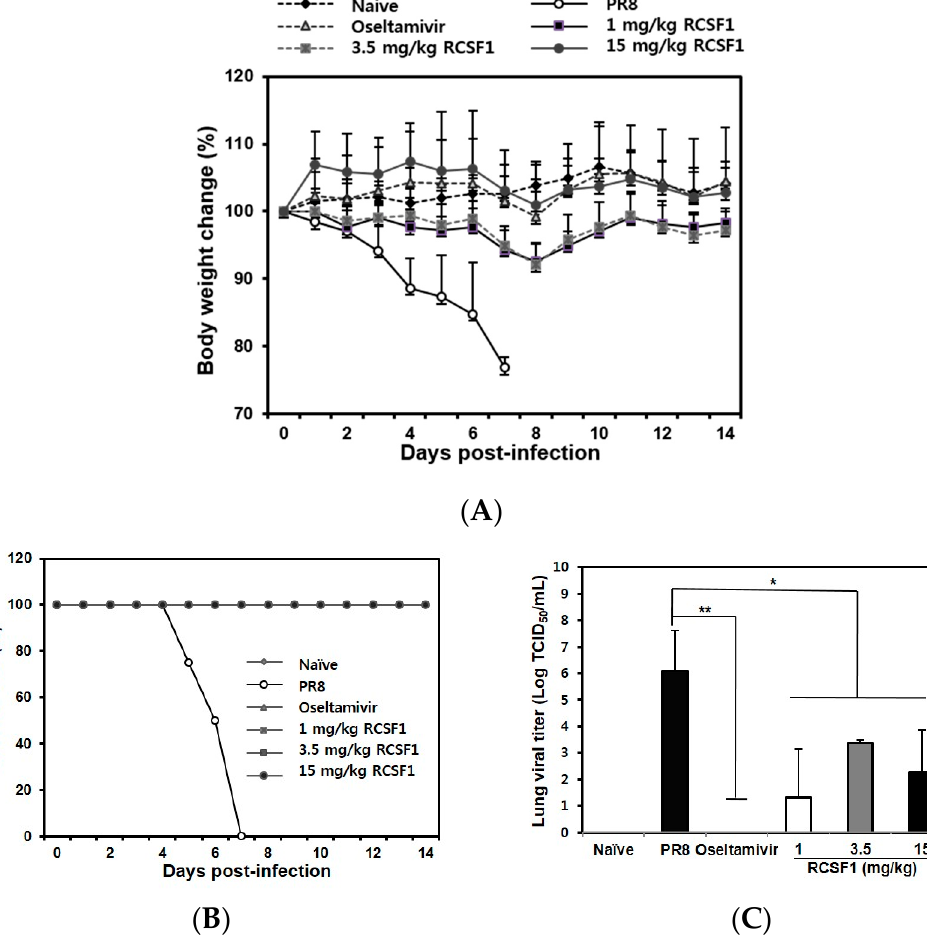
Figure 4. In vivo efficacy of RCSF1. Six groups (eight per group) were assigned: naive, negative control (PBS), positive control (oseltamivir phosphate, 0.75 mg/kg/day) and RCSF1 (1, 3.5, and 15 mg/kg/day). ( A ) Body weight changes; ( B ) survival rate until 14 dpi; and ( C ) viral lung titers by TCID 50 at 3 dpi in BALB/c mice infected with influenza virus. * p < 0.05; ** p < 0.01.